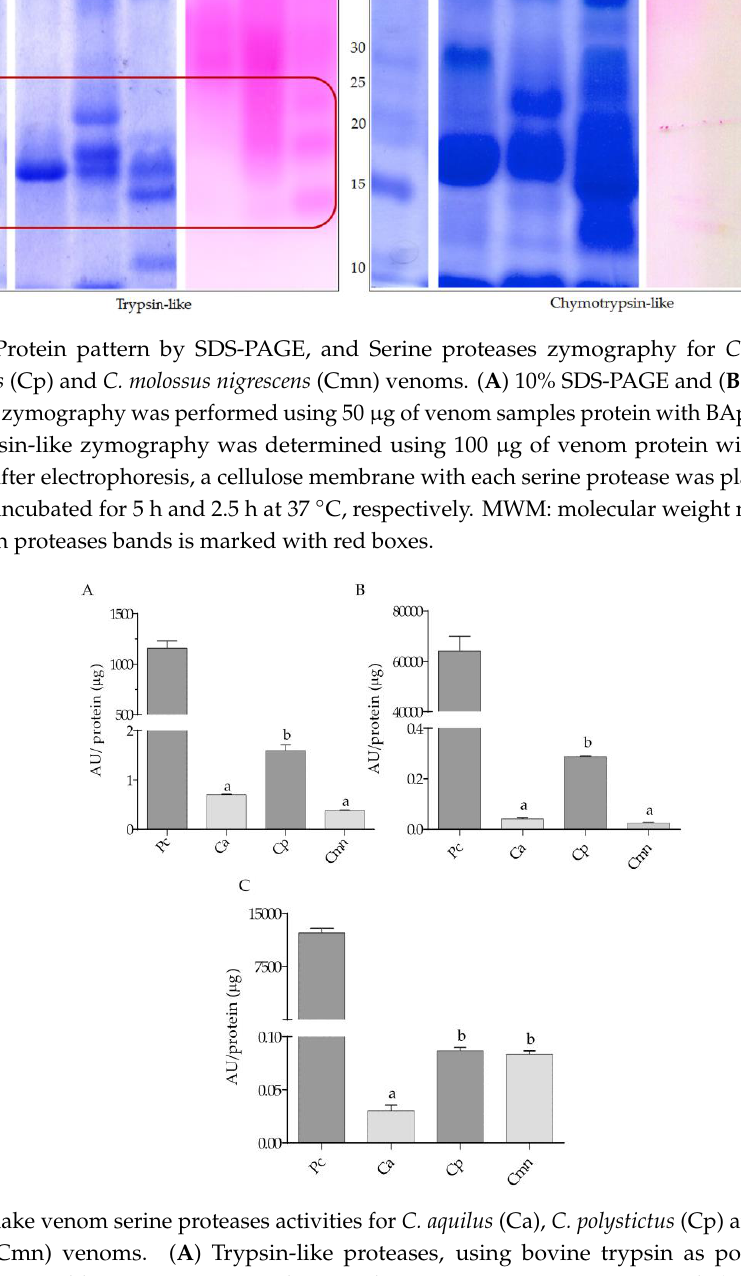
Figure 3. Snake venom serine proteases activities for C. aquilus (Ca), C. polystictus (Cp) and C. molossus nigrescens (Cmn) venoms. ( A ) Trypsin-like proteases, using bovine trypsin as positive control; ( B ) chymotrypsin-like proteases, using bovine chymotrypsin as positive control; ( C ) elastase-like proteases, using porcine elastase as a positive control. Enzymatic activity expressed in activity units (AU/µg). Small letters show significant differences (Tukey p < 0.05) between samples for each enzyme, positive controls (Pc) were not compared.